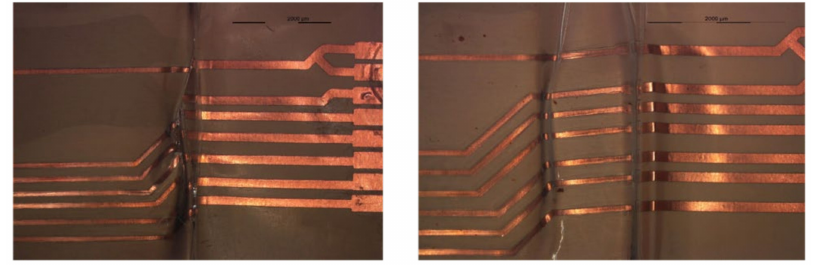
Figure 33. Compressed copper tracks at 2000 µ m